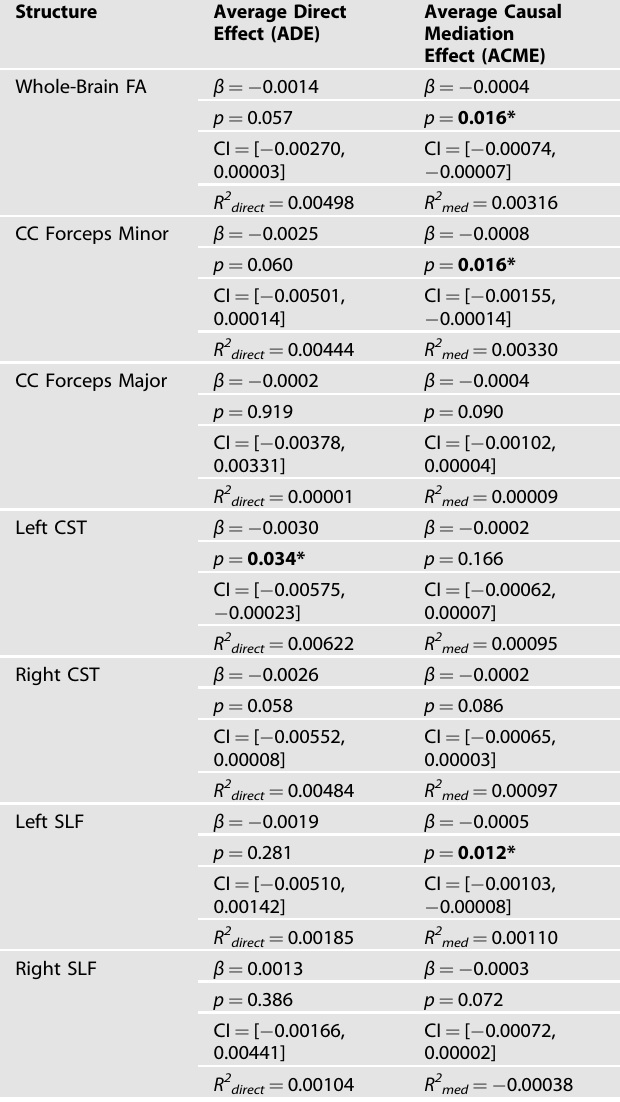
Table 4. Summary of causal mediation analysis